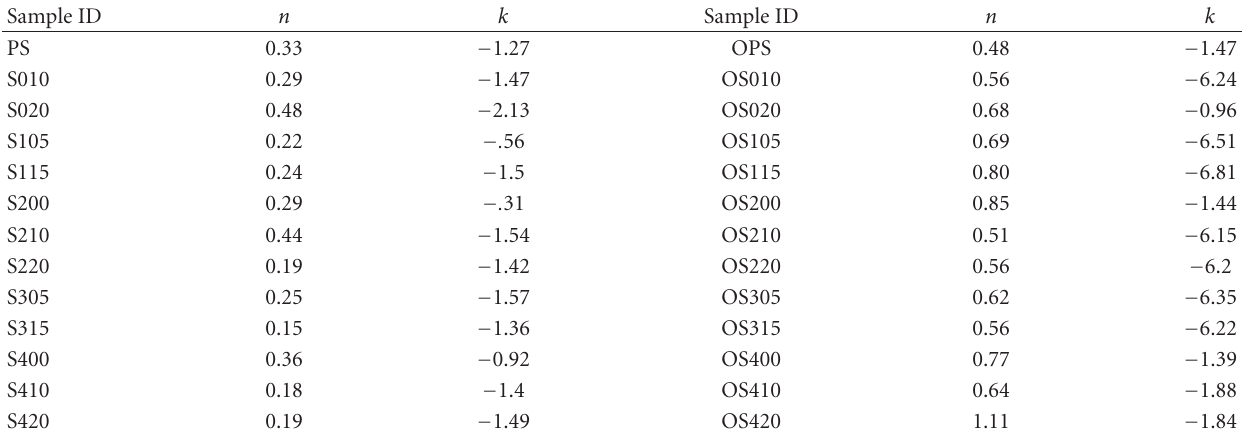
Table 3: The exponent n and the factor k obtained from a nonisothermal crystallization analysis using the modified Avrami equation for all the